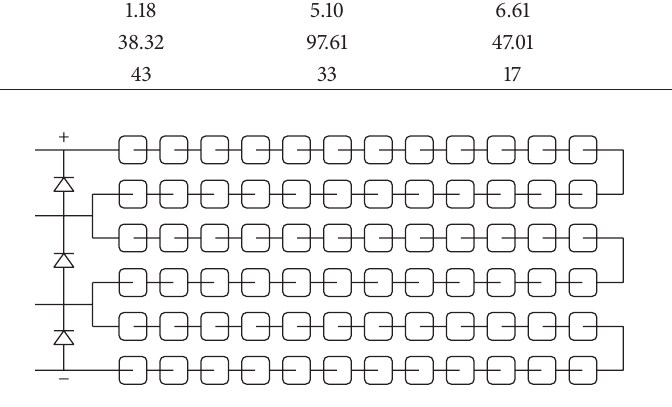
Figure 5: A schematic diagram of the PV module HH220(30)p.